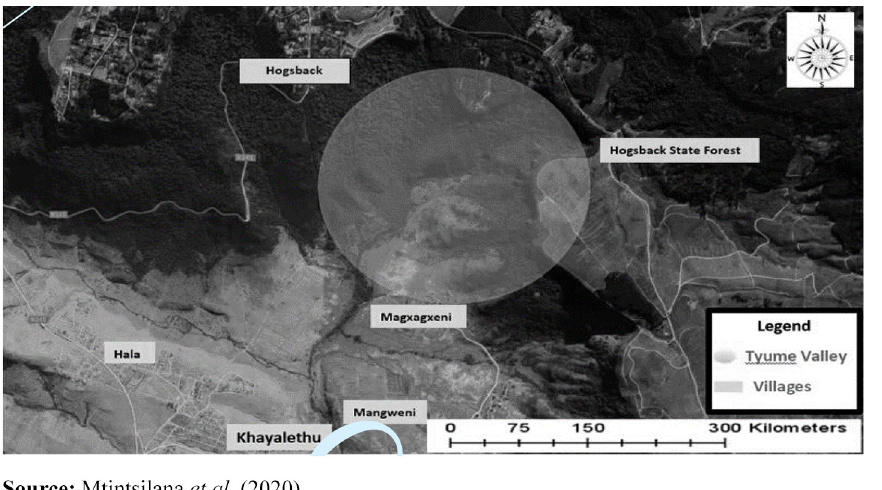
Figure 1. Tyhume Valley